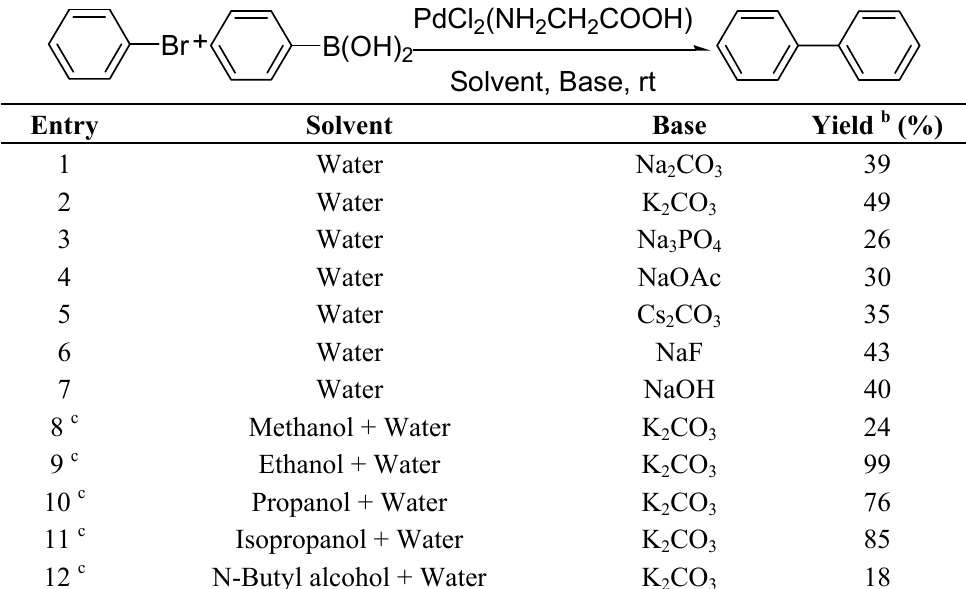
Table 1. The effects of base and solvent on the cross-coupling of bromobenzene and phenylboronic acid.